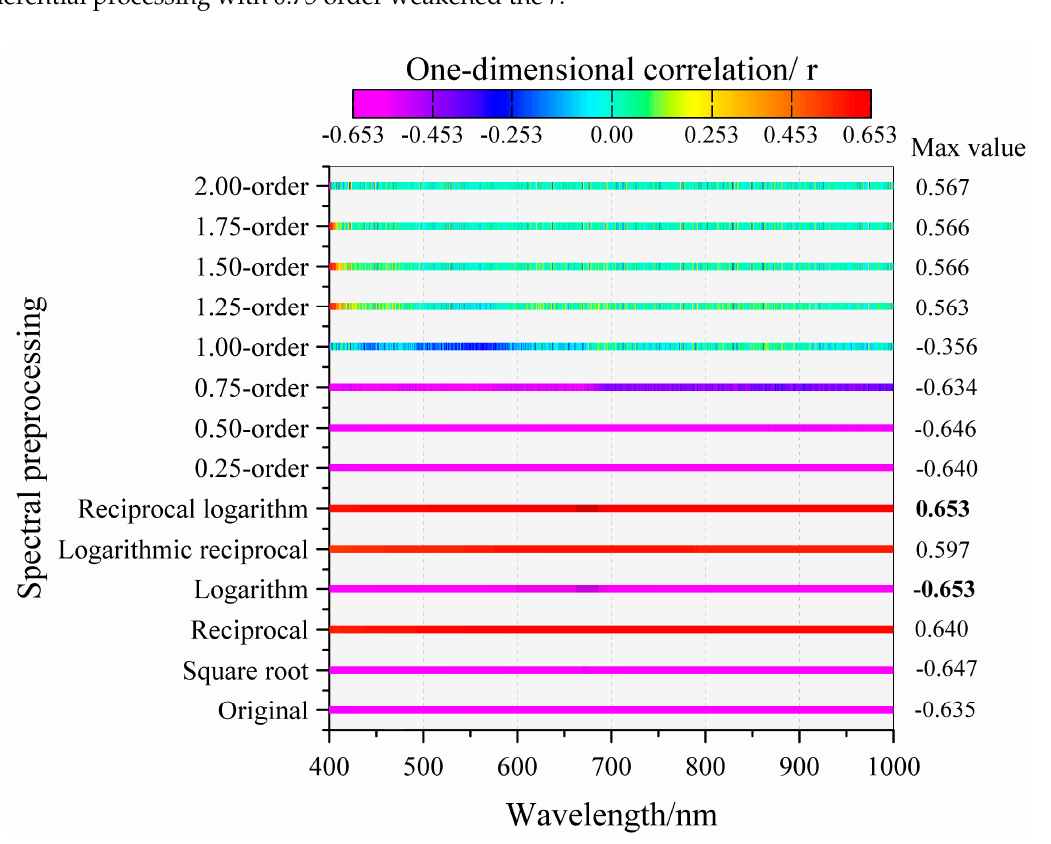
Figure 10. One-dimensional r diagram between SMC and 0.5-order absorbance spectrum.